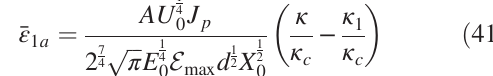
FIG. 6. The relations ε 1 a = ¯ ε 1 a (the partial probability of volume capture to its linear approximation) (a) and ε 1 = ¯ ε 1 (the total probability of volume capture to its linear approximation) (b) as functions of the x-value, where X ¼ ð R=R c − κ 1 Þ = κ c and κ 1 ; κ c - values are taken from Table V (see text). Numbers near curves are the same as in Fig.